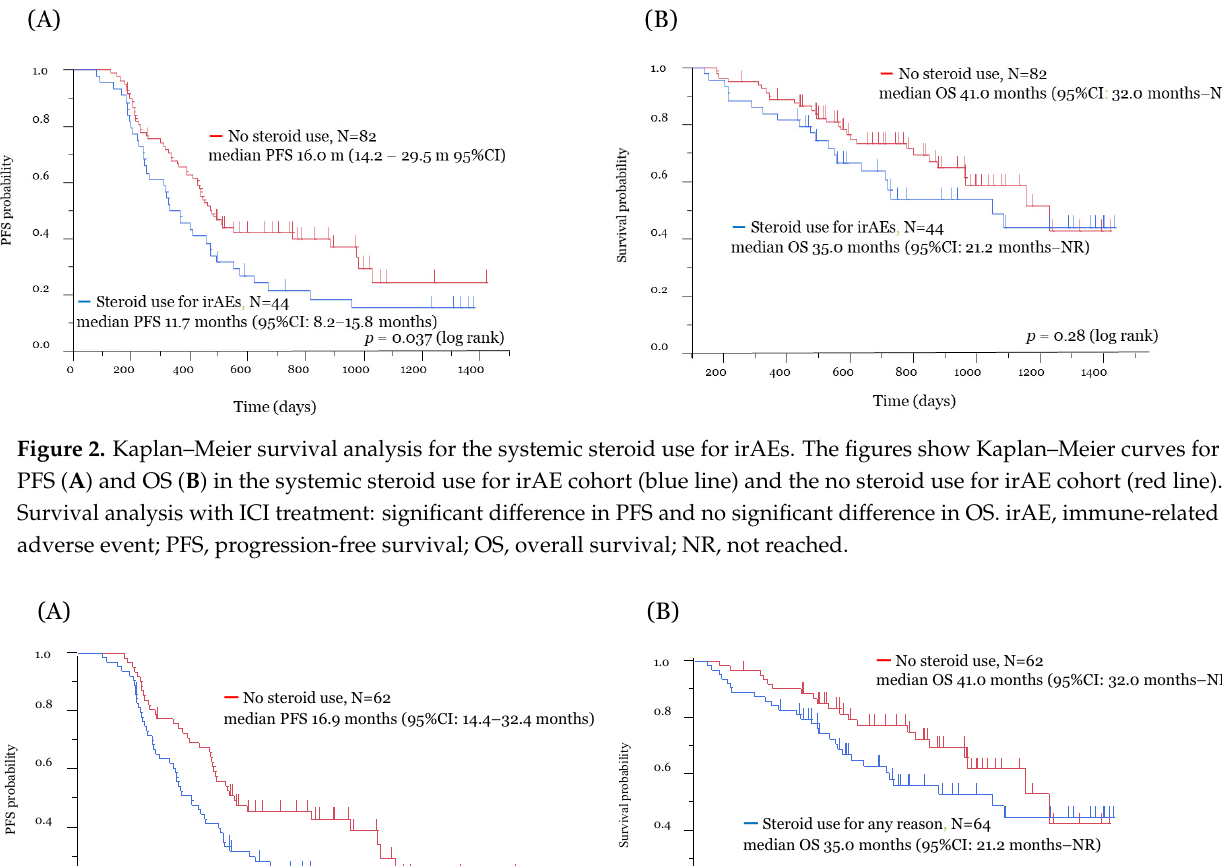
ー Steroid use for any reason,N=64 median PFS 12.3 months (95%CI: 9.9–5.4 months)